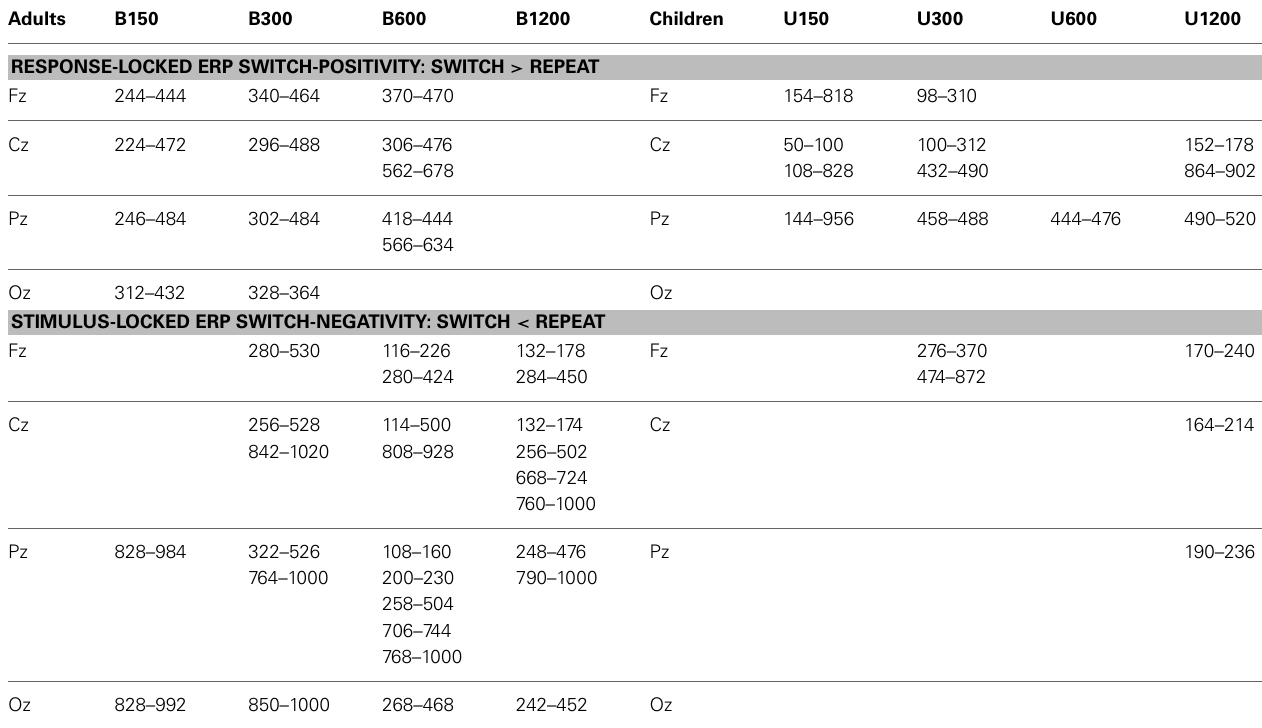
Table 2 | Areas of significant deviation from baseline for the switch-positivity in response-locked ERPs and the switch-negativity in stimulus-locked ERPs for Experiment 3 ( p < 0 . 05 after correction using (Guthrie and Buchwald, 1991) criteria, see Methods for more